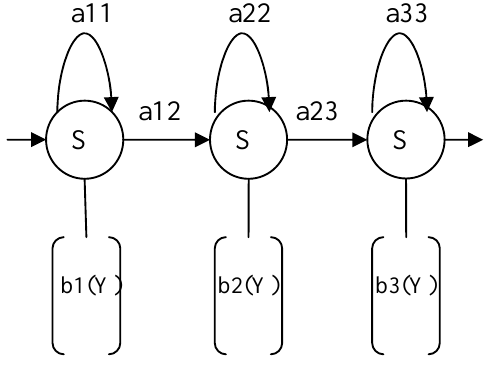
Fig. 3. Structure of left-right